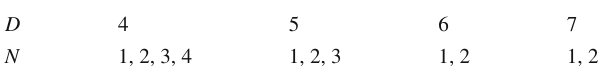
Table 1 All possible values of N for gauged supergravities in various dimensions D N 1, 2, 3, 4 1, 2, 3 1, 2 1,